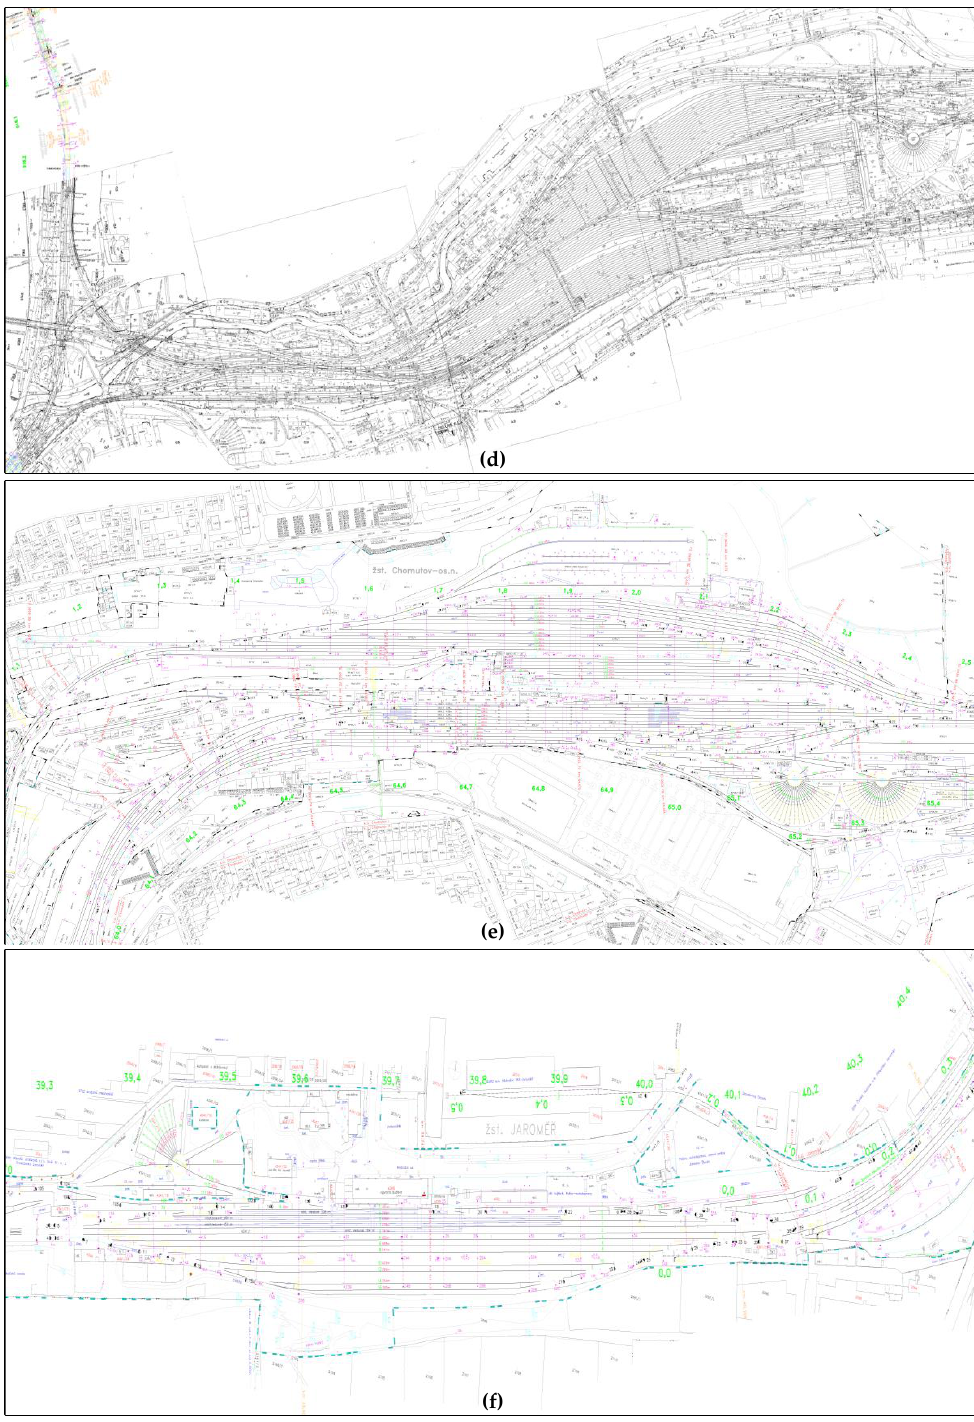
Figure 3. The railway infrastructures: ( a ) Pardubice; ( b ) Hradec Kralove; ( c ) Kolin; ( d ) Usti nad Labem; ( e ) Chomutov; ( f ) Jaromer.